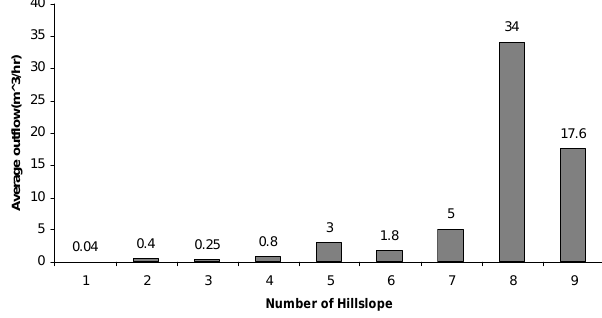
Fig. 11. Average subsurface flow for nine basic hillslopes